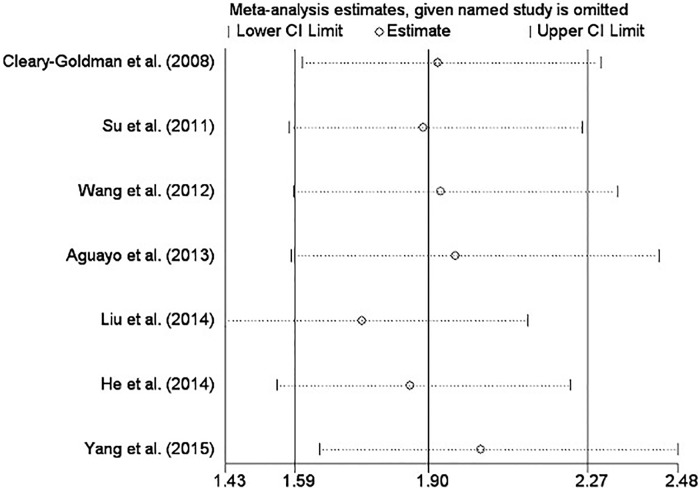
The sensitivity analysis of the included studies reporting relevant data on the association of SCH without intervention and miscarriage.